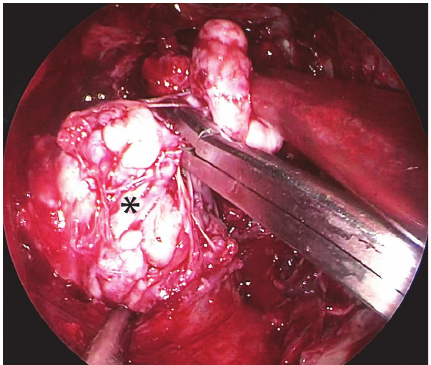
Figure 5: Endoscopic view showing the tumor ( ∗ ) being pushed superiorly.